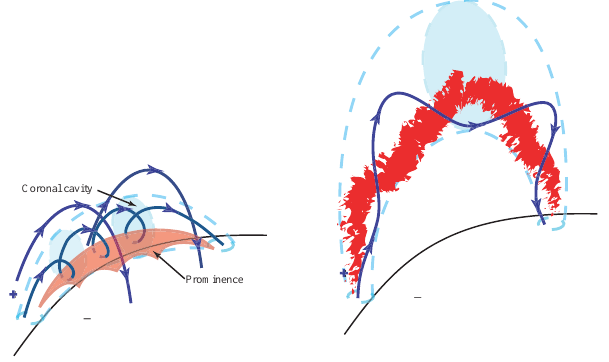
Fig. 5. A sketch of the 3-D geometry of a magnetic flux rope with a coronal cavity and a prominence inside in equilibrium (left) and during eruption